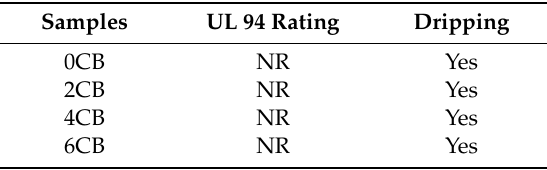
Table 6. UL- 94 test data of gluten / CB biocomposites.